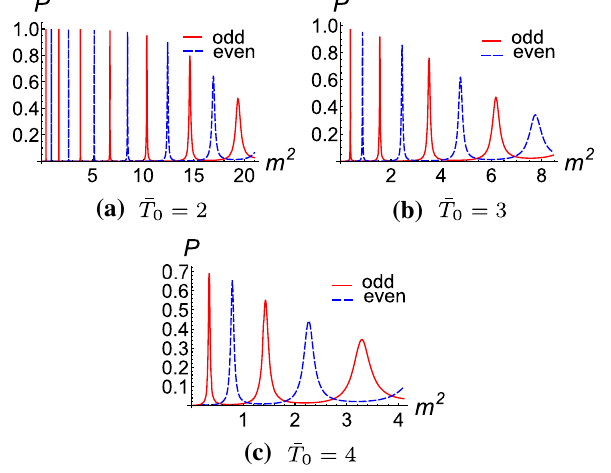
Fig. 11 Plot of the effective potential for f ( T ) = −